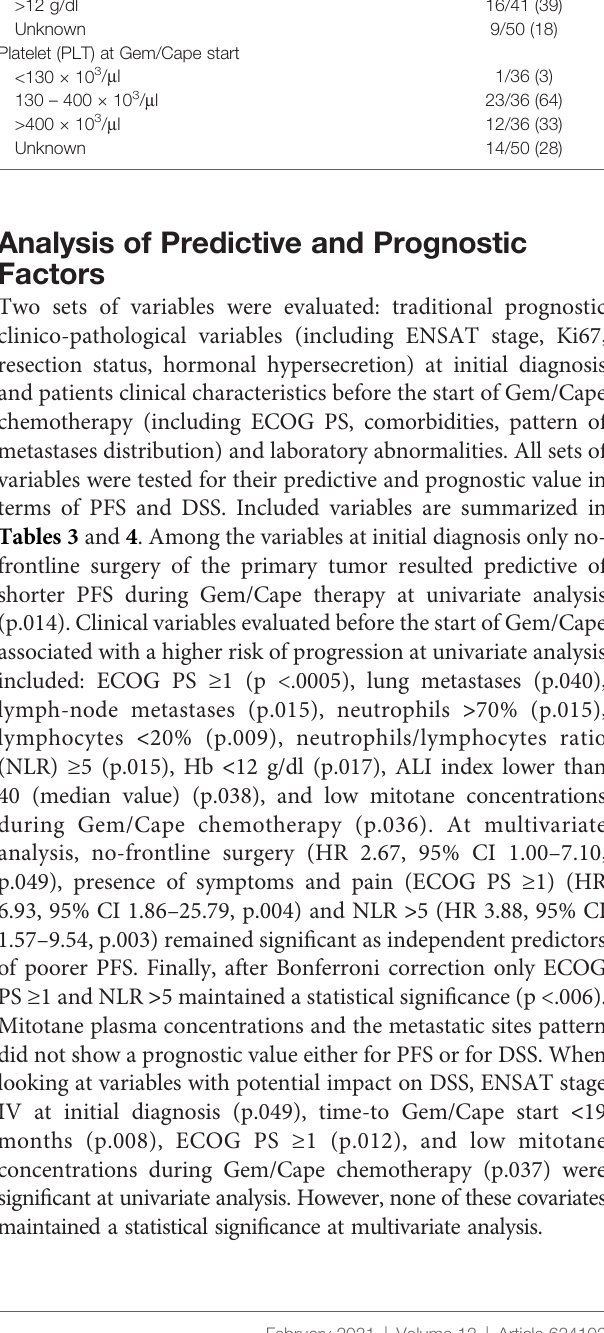
PS ≥ 1 and NLR > 5 maintained a statistical signi fi cance (p <.006). Mitotane plasma concentrations and the metastatic sites pattern did not show a prognostic value either for PFS or for DSS. When looking at variables with potential impact on DSS, ENSAT stage IV at initial diagnosis (p.049), time-to Gem/Cape start < 19 months (p.008), ECOG PS ≥ 1 (p.012), and low mitotane concentrations during Gem/Cape chemotherapy (p.037) were signi fi cant at univariate analysis. However, none of these covariates maintained a statistical signi fi cance at multivariate analysis.